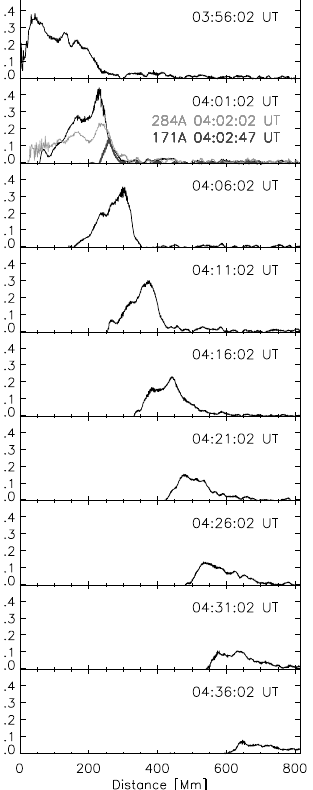
Figure 27: Perturbation profile evolution in the coronal wave of 2010 Jan 17 (cf. Figure 19) derived from STEREO/EUVI data. The profiles are derived from running ratio images at 195 ˚A. Amplitude decrease and perturbation width increase are clearly seen. Image reproduced with permission from Veronig et al. (2010), copyright by